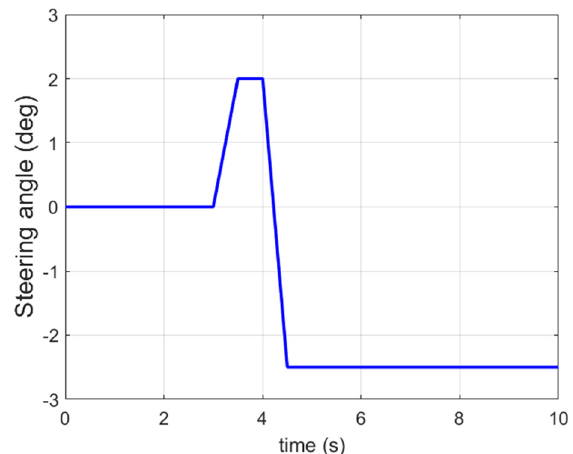
Figure 18. Input steering angle in the third set of simulations.